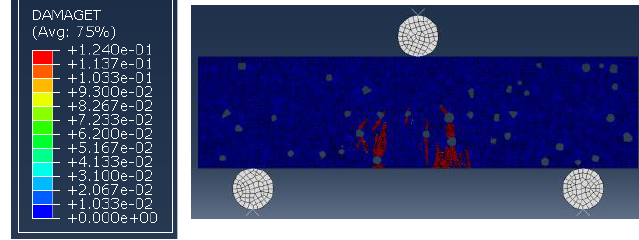
Figure 24. Pore-based mesoscale model of the 2D CRM12 sample.